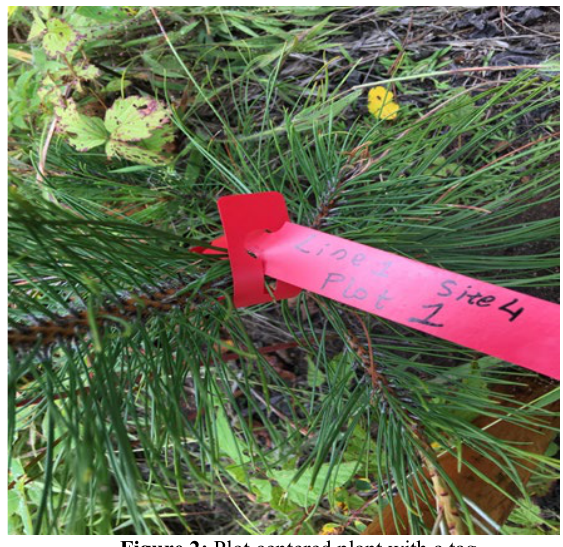
Figure 2: Plot centered plant with a tag